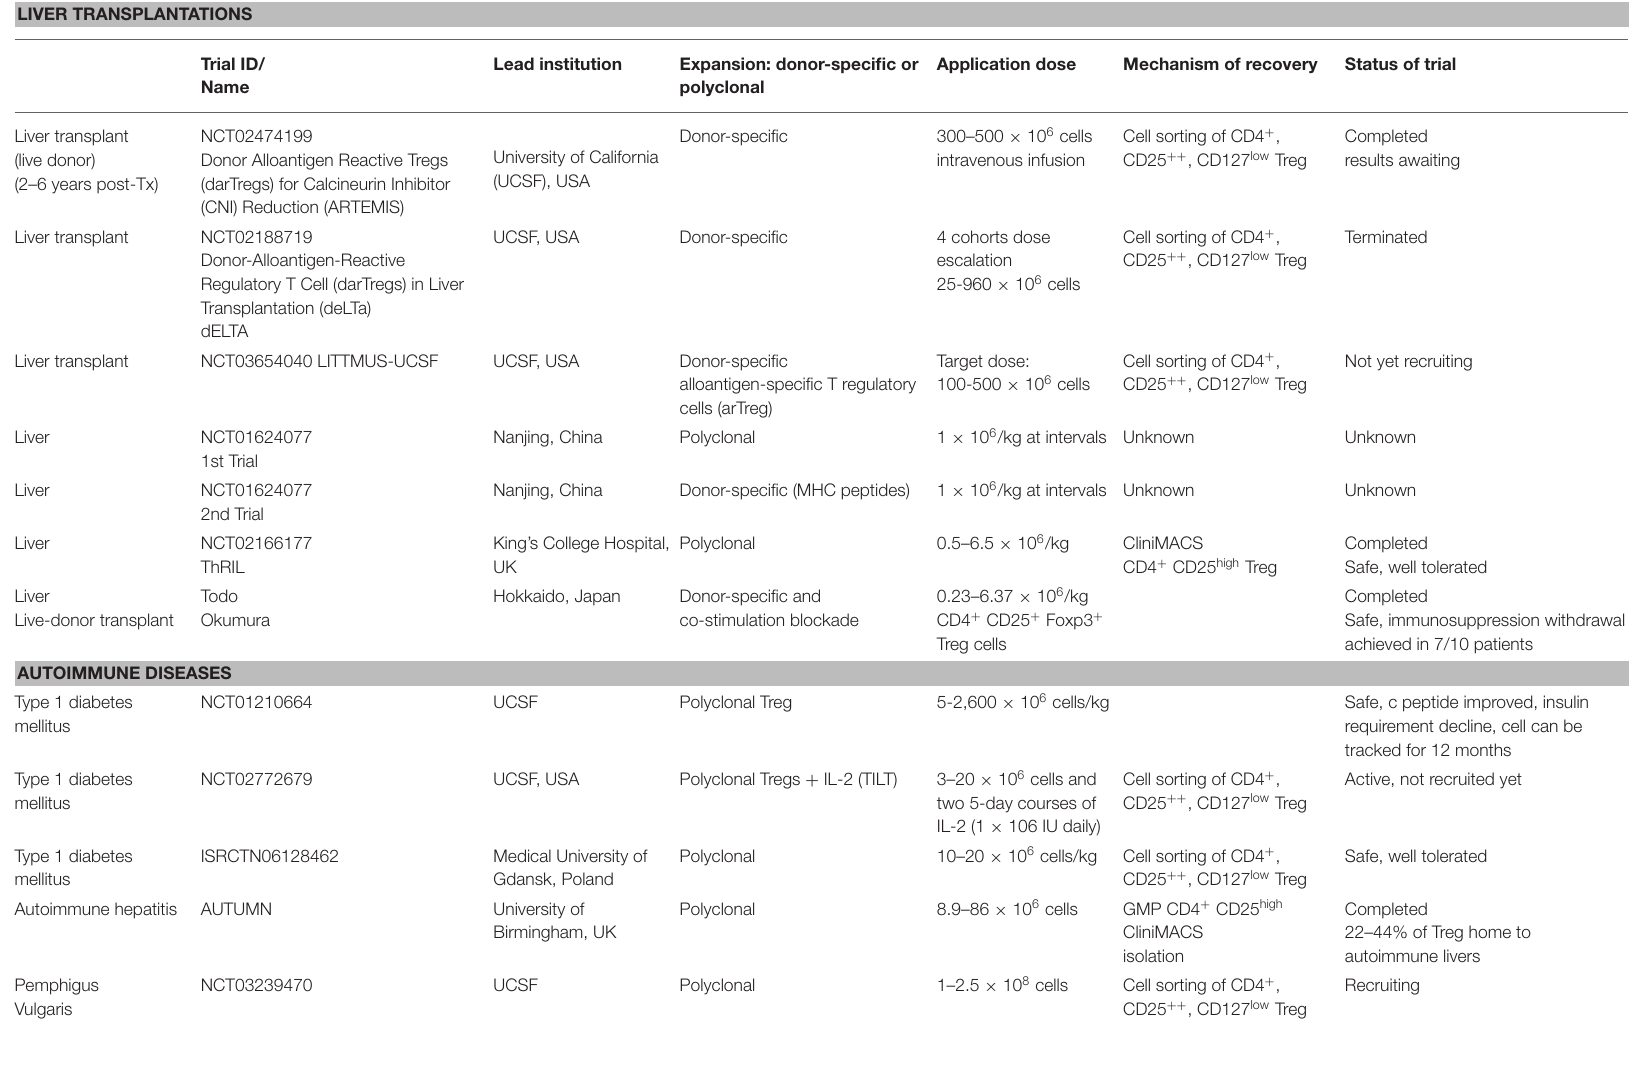
TABLE 1 | Table summarizing clinical applications of Treg cells in liver and autoimmune diseases in current clinical trials. LIVER